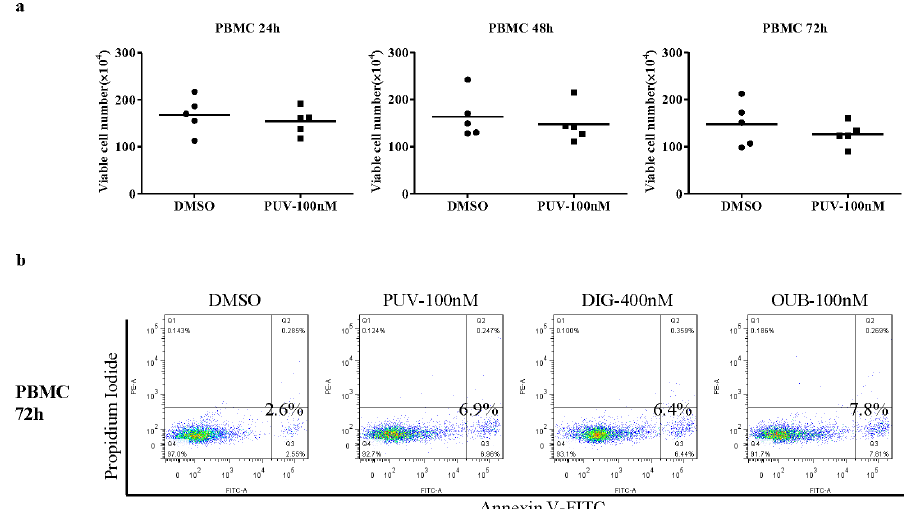
Figure 3. Peruvoside did not show obvious cytotoxicity on normal human peripheral blood mononuclear cells (PBMCs). ( a ) Viable cell numbers at different time points after Peruvoside treatment; ( b ) Flow cytometry analysis of Annexin V and PI expression in PBMCs after being treated with various CGs for 72 h. PUV, Peruvoside; DIG, Digitoxin; OUB, Ouabain.